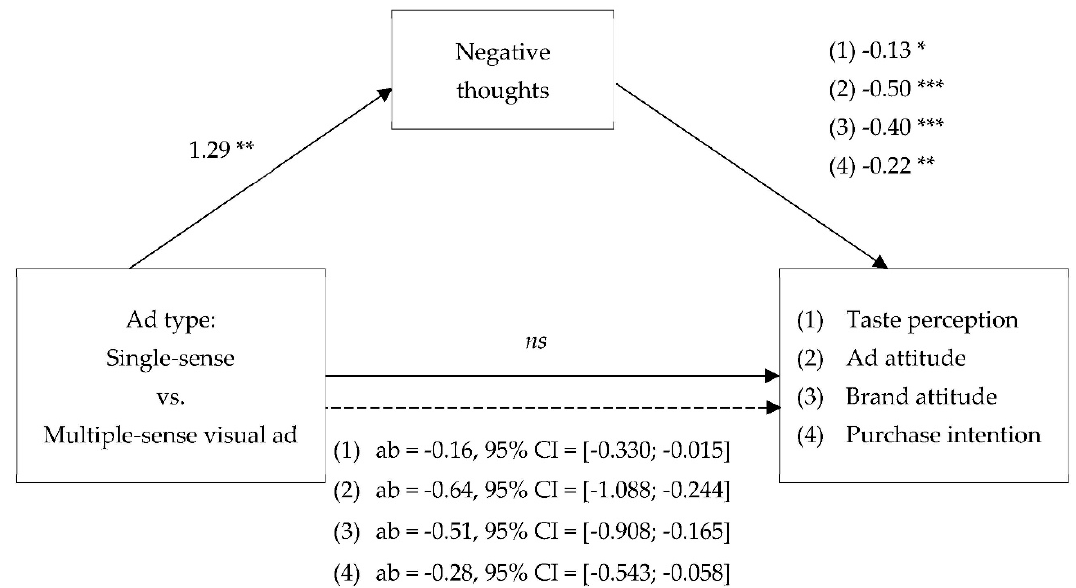
Figure 4. Results of Study 2. The effect of ad type on ad effectiveness is mediated by negative thoughts. Note: Other thoughts ( t (80) >= − 2.00, p < 0.05); *** significant at p < 0.001; ** significant at p <